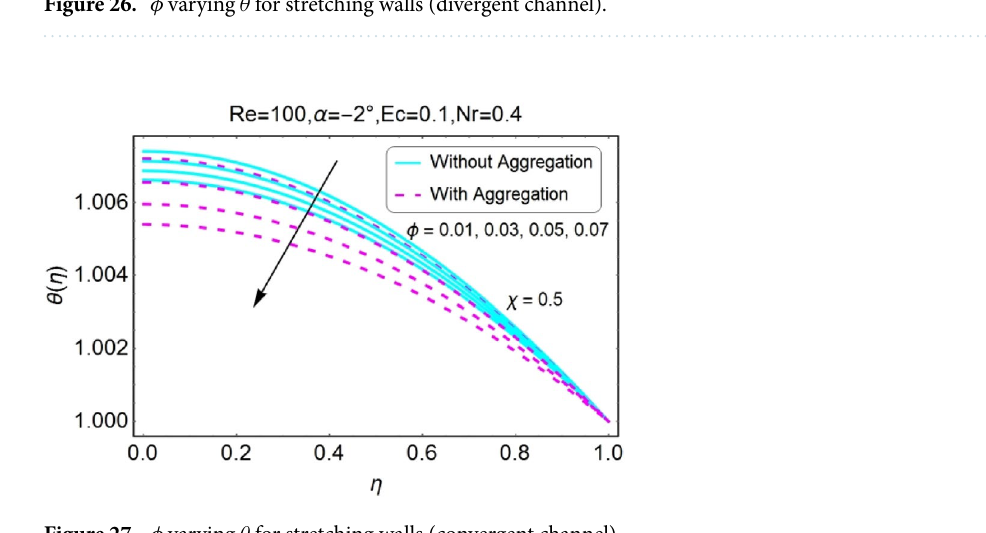
Figure 27. φ varying θ for stretching walls (convergent